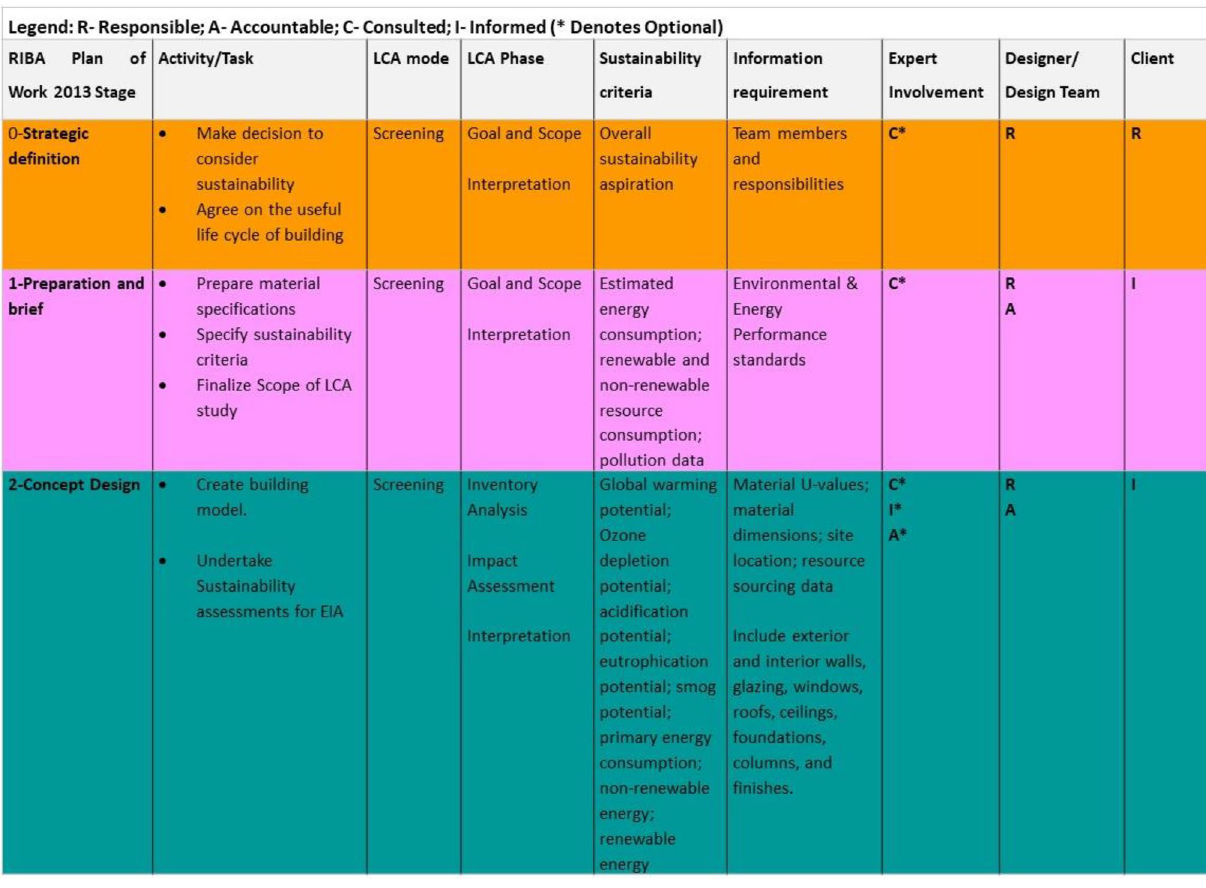
Table 8 Guidance matrix